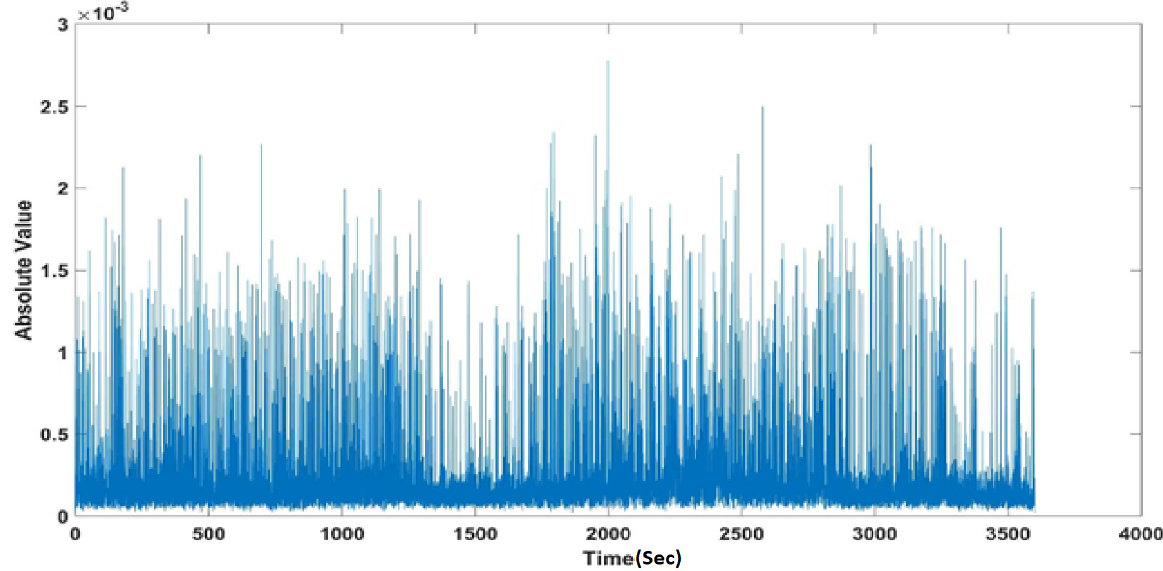
Figure 4. Output for chb01_01, using the proposed seizure-detection algorithm, shows no seizure